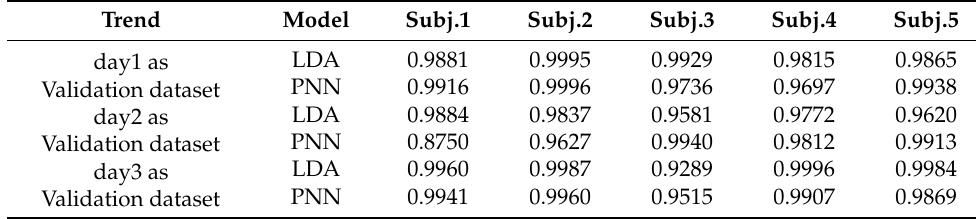
Table 5. Correlation analysis on each subject for the influence of acquisition time.